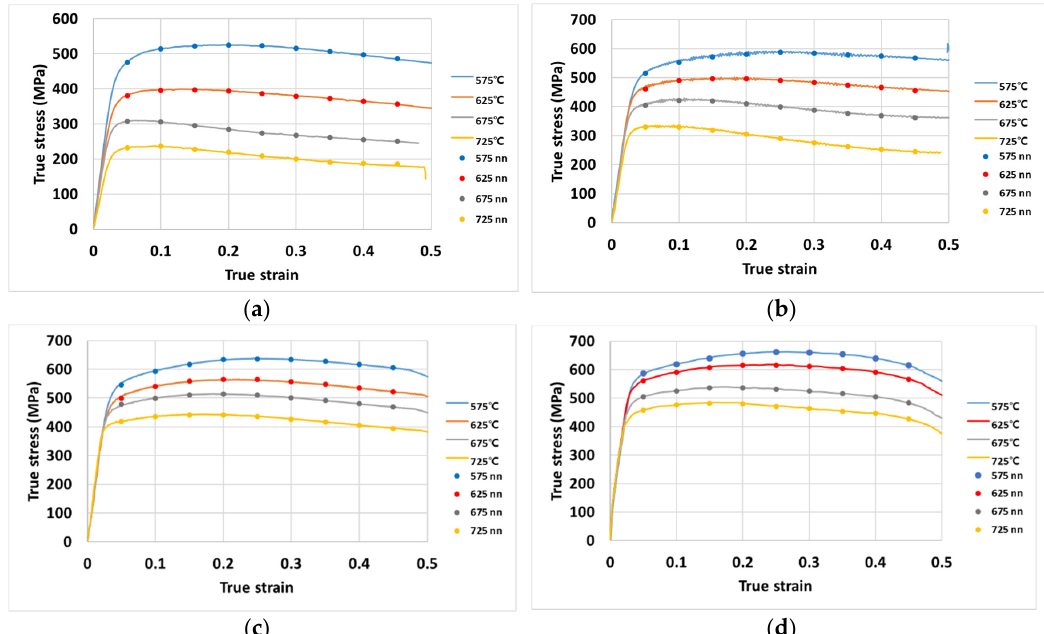
Figure 7. Predicted stress by neural network model at: ( a ) 0.002 s − 1 ; ( b ) 0.02 s − 1 ; ( c ) 2 s − 1 ; ( d ) 20 s − 1 .